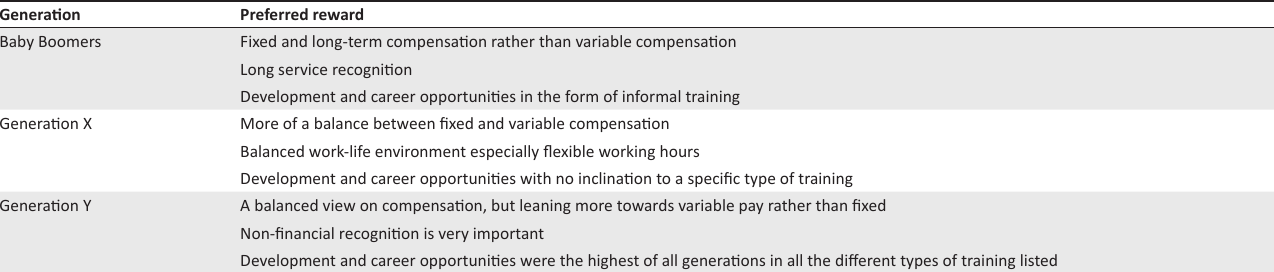
TABLE 9: Preferred reward for the different generations in the company. Generation